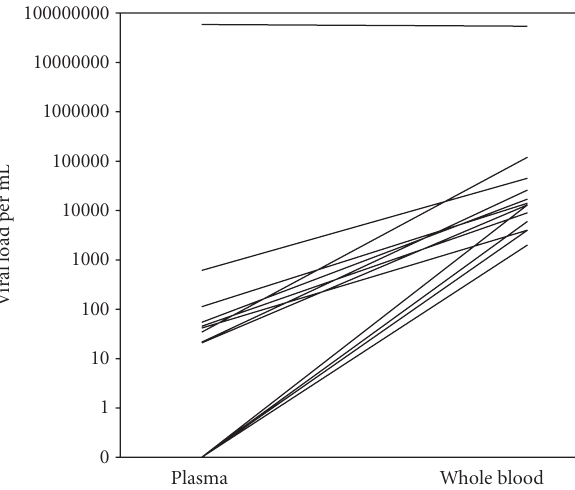
Figure 2: EBV DNA load analysed by quantitative PCR in whole blood compared to plasma of SOT patients ( n = 15).